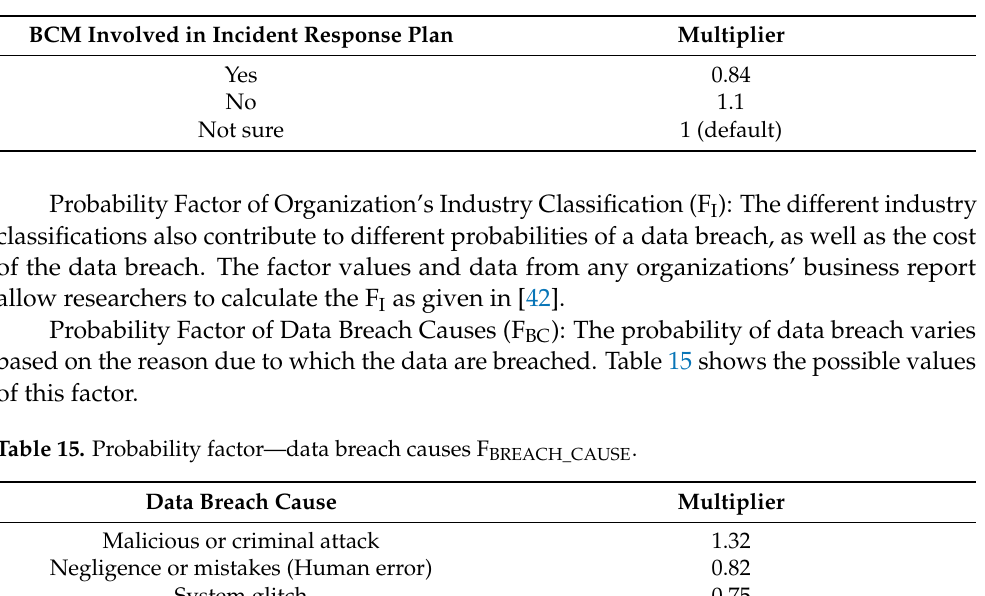
Table 14. Probability factor for F BCM .